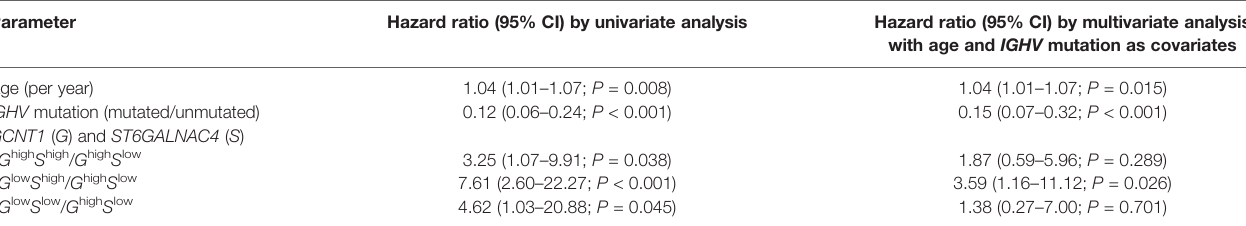
AnalysesoftheassociationofGCNT1andST6GALNAC4 withmortality,with orwithoutclinicalcovariates, wereperformed usingInternational CancerGenome Consortiumdata(n=264) as described inMethods. Thecutoffvalueforsample subgroupingwas basedon theoptimalcutofffor geneexpression (3.3and 10.3forGCNT1 andST6GALNAC4, respectively) fi ttedin the Cox proportional hazards model. P values are based on likelihood ratio test. CI, con fi dence